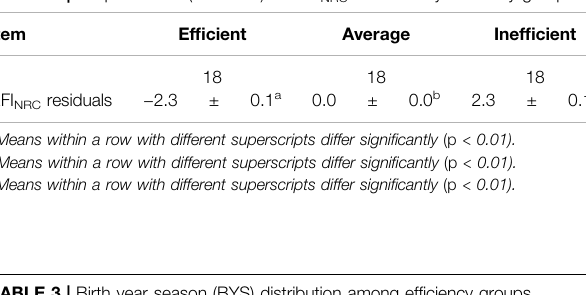
TABLE 3 | Birth year season (BYS) distribution among ef fi ciency groups.